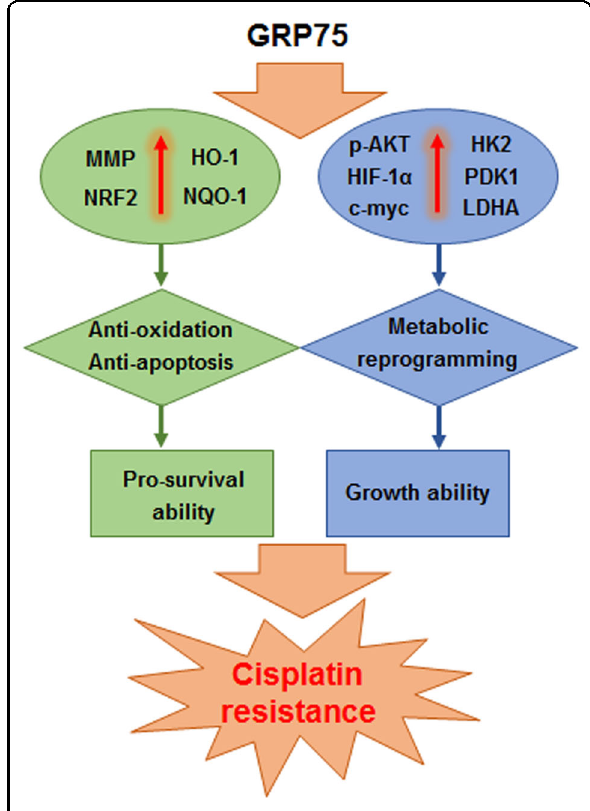
Fig. 8 The possible mechanisms of GRP75 promoting the survival/growth of GC cells. A hypothetic scheme showed that overexpression of GRP75 could promote survival/growth in GC cells by regulating anti-oxidation/apoptosis and metabolic reprogramming networks, thereby inducing